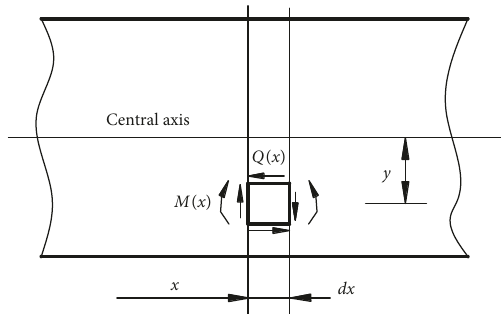
Figure 5: Forces applied to microelements of bending beam subject to lateral